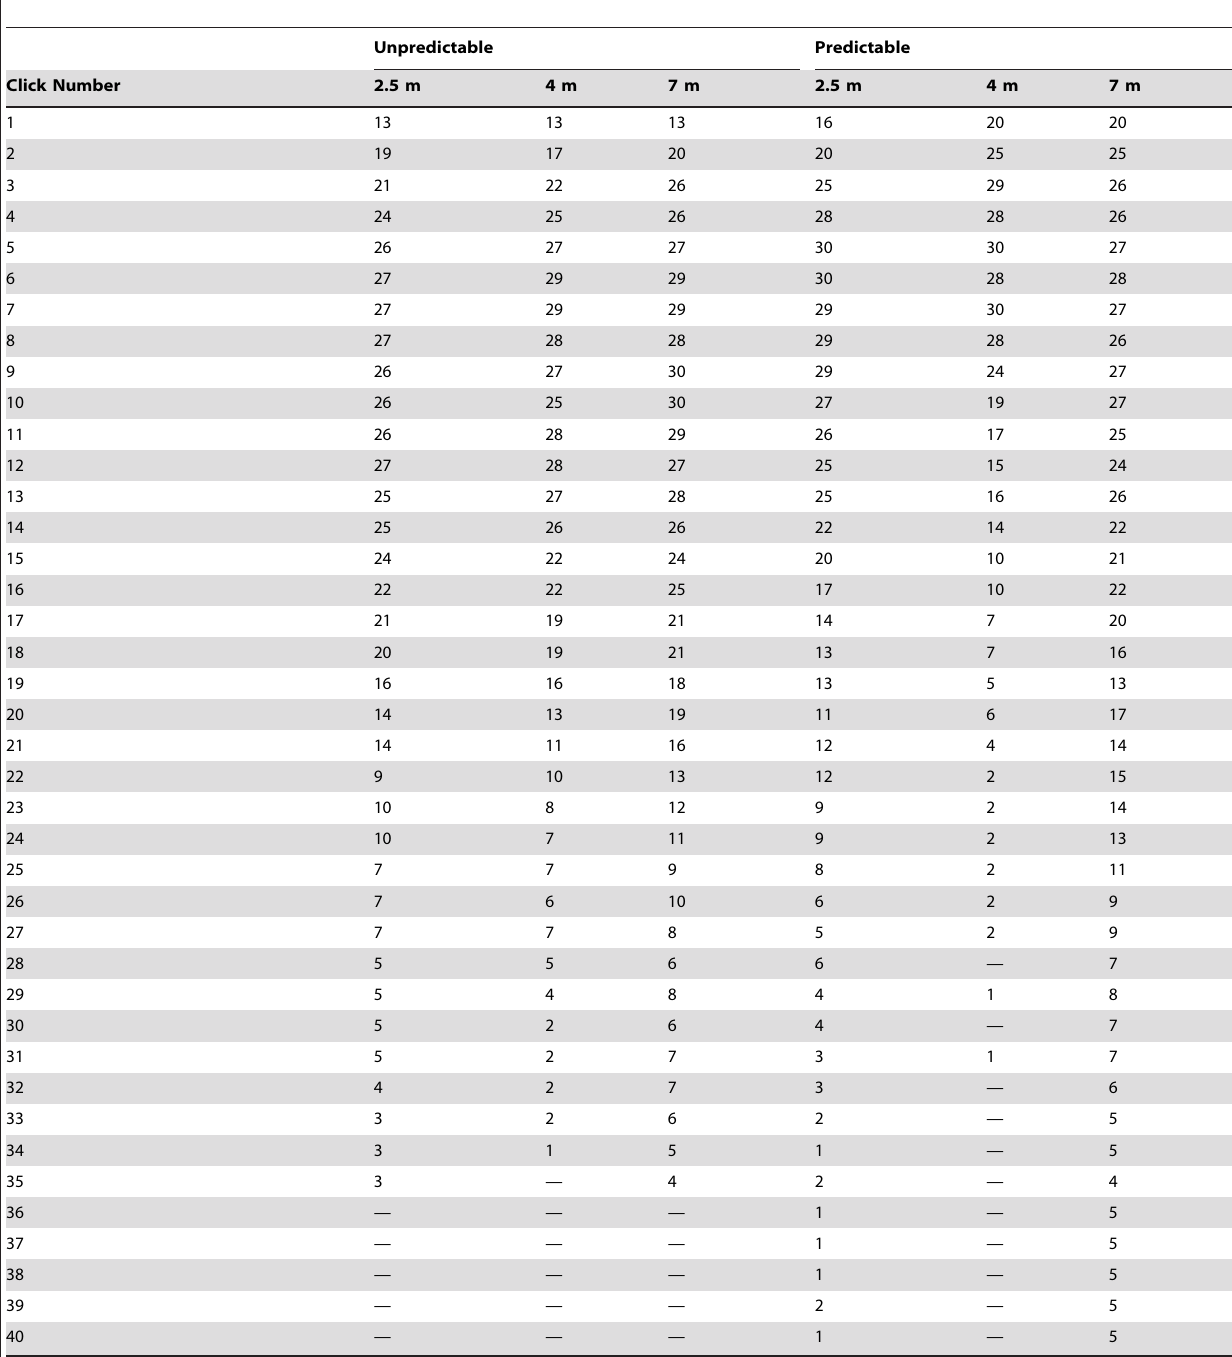
Table 1. Number of data points (clicks) for each averaged click number represented in Figure 3.